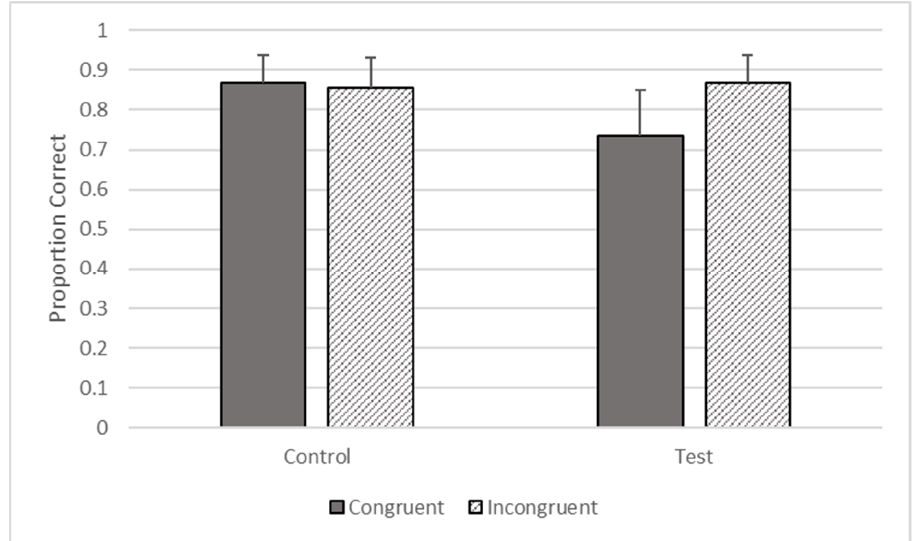
Figure 6. Proportion of trials correct as a function of trial types in Phase Four.